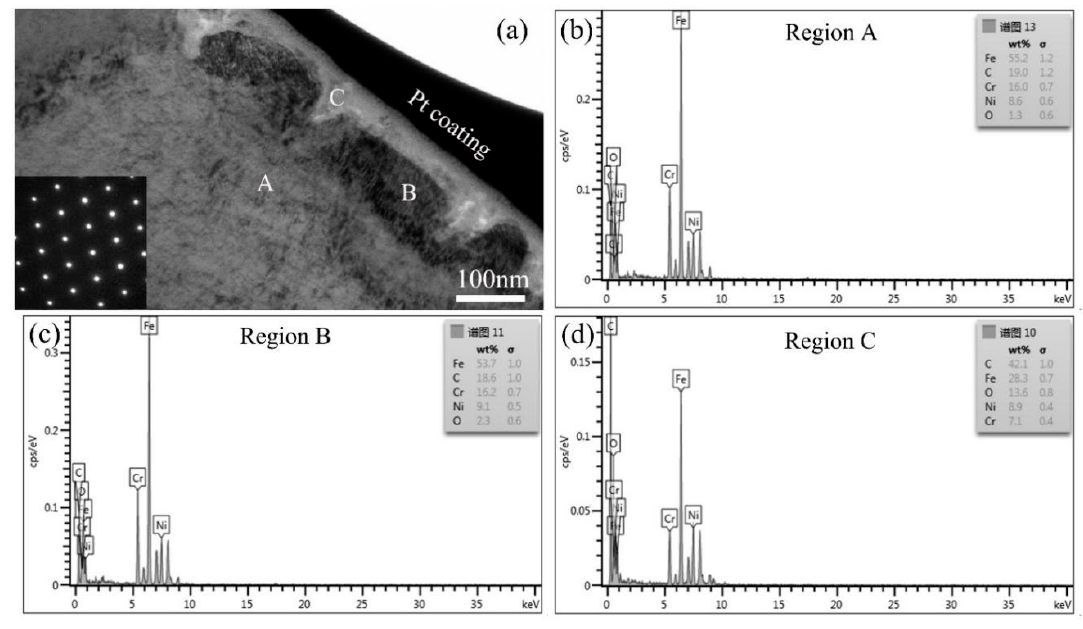
Figure 8. ( a ) Cross-sectional bright field TEM image of sample #12; ( b – d ) EDS results of locations ‘A’, ‘B’, and ‘C’ in ( a ), respectively. Table 4. The percentage content of the main elements in Figure 8a, wt %.